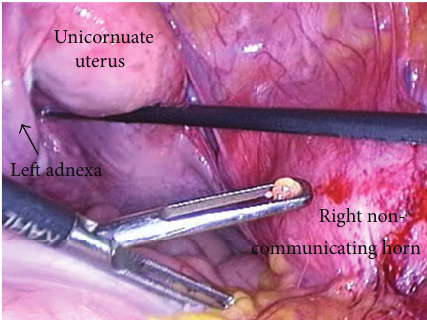
Figure 2: Several thick adhesion fixing the uterine horn to posterior and lateral pelvic